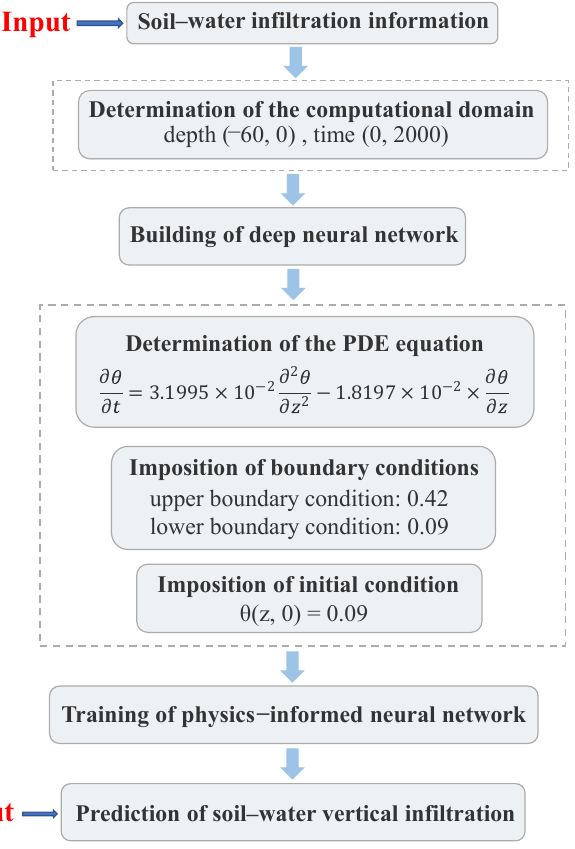
Figure 5. The detailed procedure of the PINN-based numerical